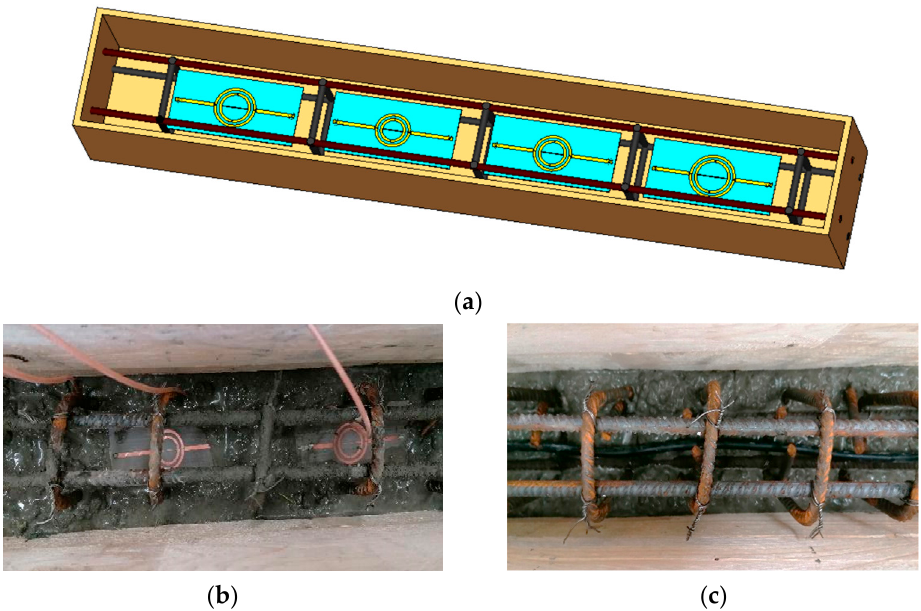
Figure 7. Scheme of the experimental setup. ( a ) 3-D view of the four SRRs embedded in the concrete beam. ( b ) Picture of the setup showing a detail of the top portion of the beam housing two SRRs during concrete pouring in the formwork. ( c ) Picture showing a detail of the bottom portion of the beam housing the diffused SE.